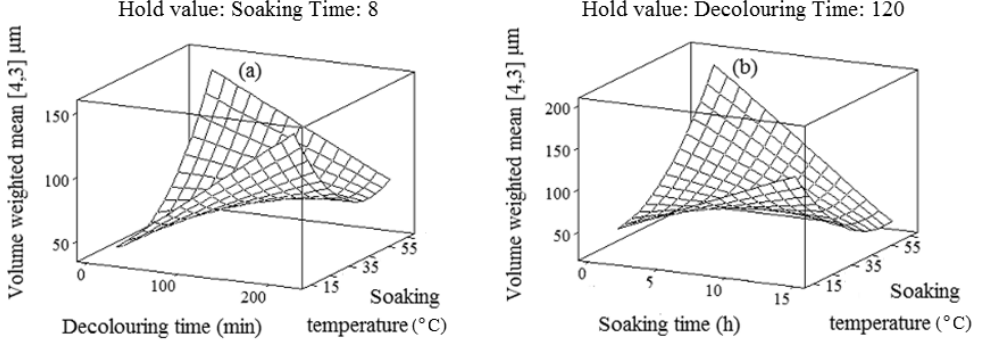
Figure 1. Response surface plots for explaining the variation of volume-weighted mean as a function of ( a ) decolouring time and soaking temperature and ( b ) soaking time and soaking